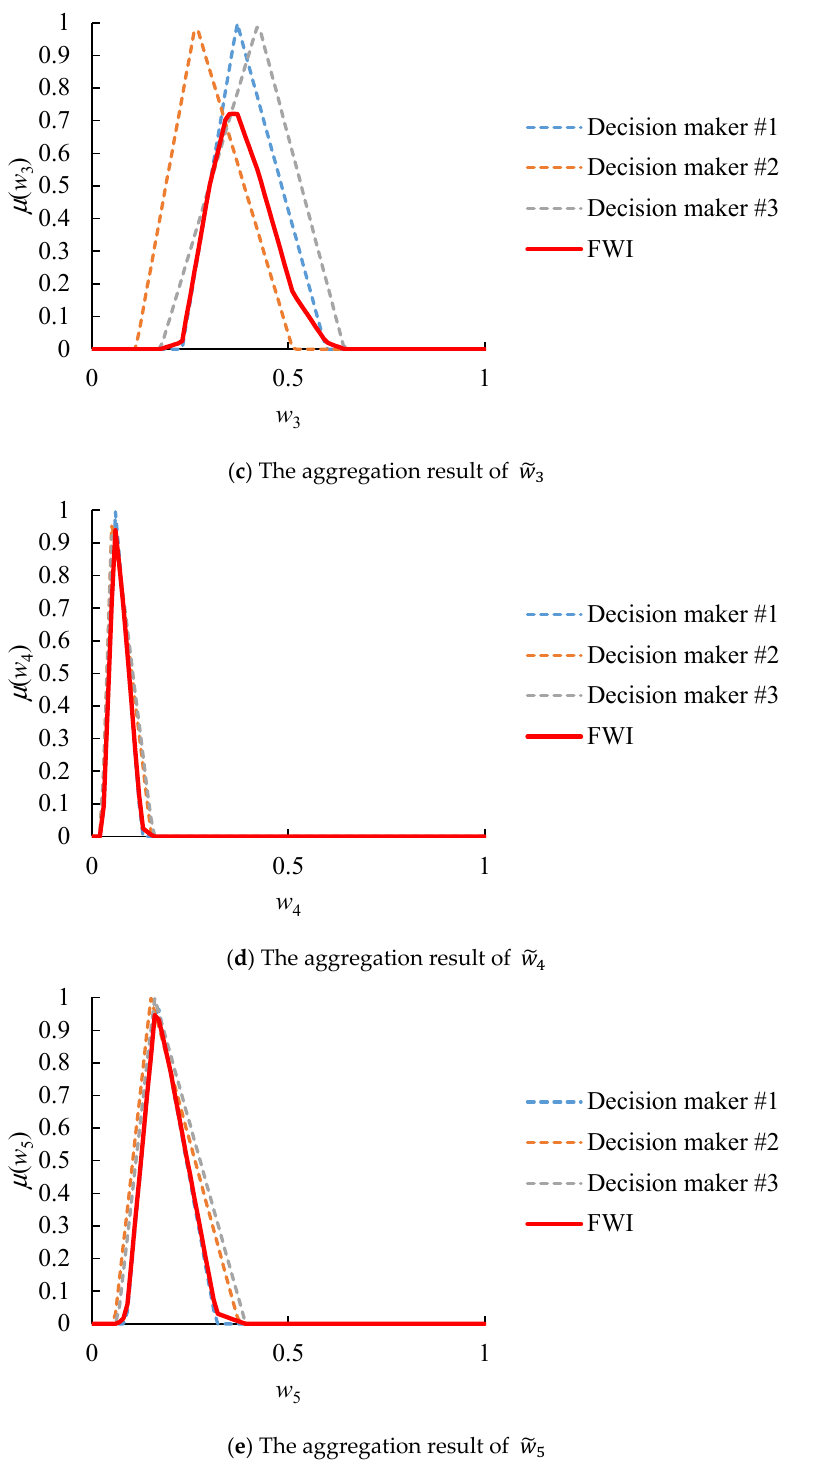
Figure 6. Aggregation results. To facilitate subsequent operations, the polygonal aggregation result was approxi- mated with a TFN, as shown in Figure 7.